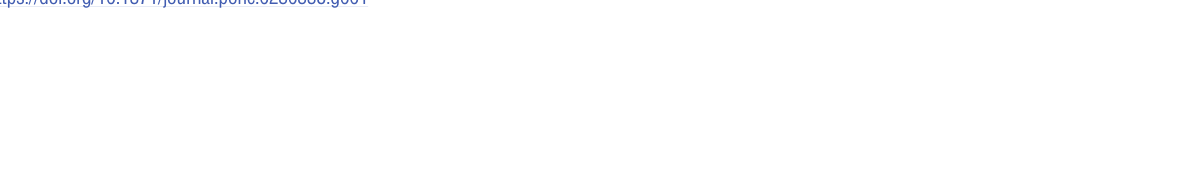
PLOS ONE | https://doi.org/10.1371/journal.pone.0230338 March 17, 2020 5 /